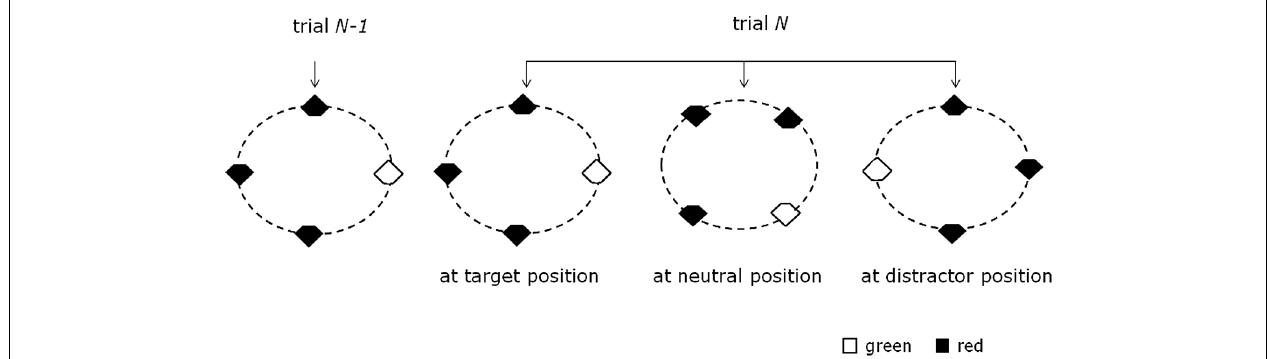
FIGURE 1 | Schematic of cross-trial target location transitions in the present study. In a given display, four out of eight locations were occupied by the search items (one target, three distractors). The four items could form either a virtual square or diamond configuration. The